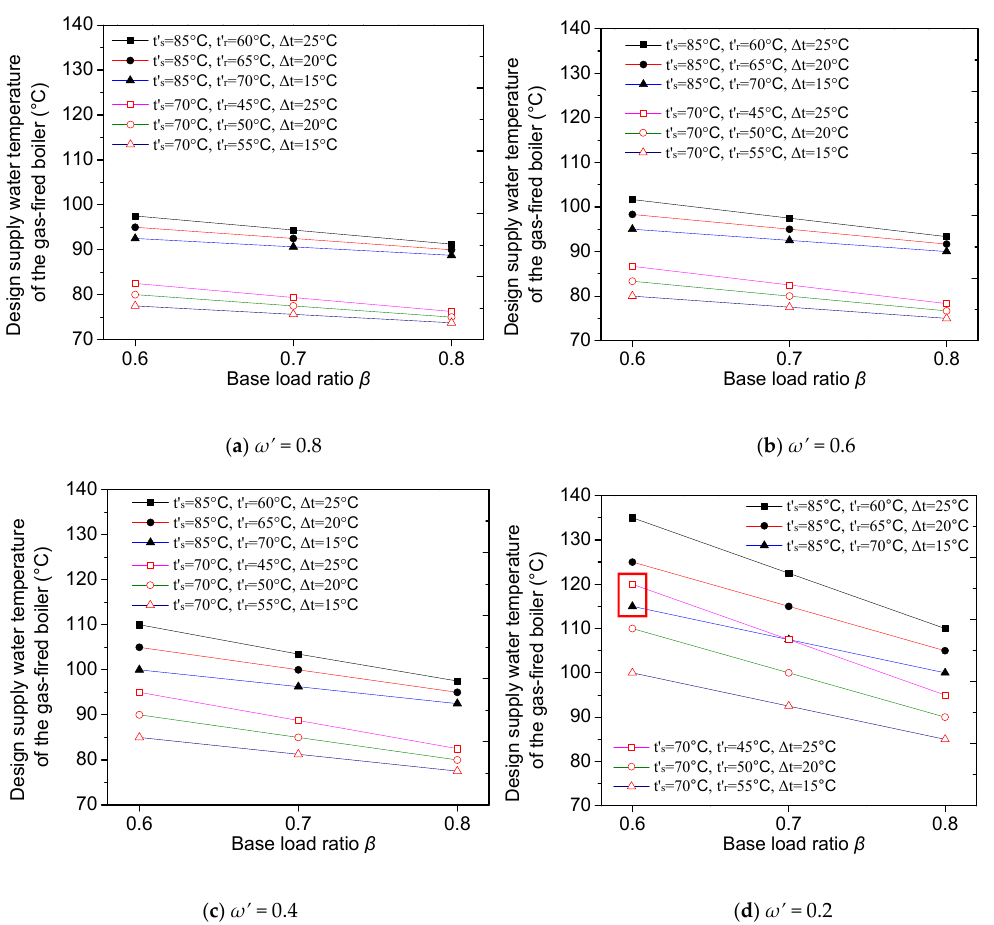
Figure 3. Variation of design supply water temperature of the heat exchanger ( 𝑡 (cid:3046),(cid:3035)(cid:3045), ) with different network temperature levels and base load ratio ( β ) for series connection.